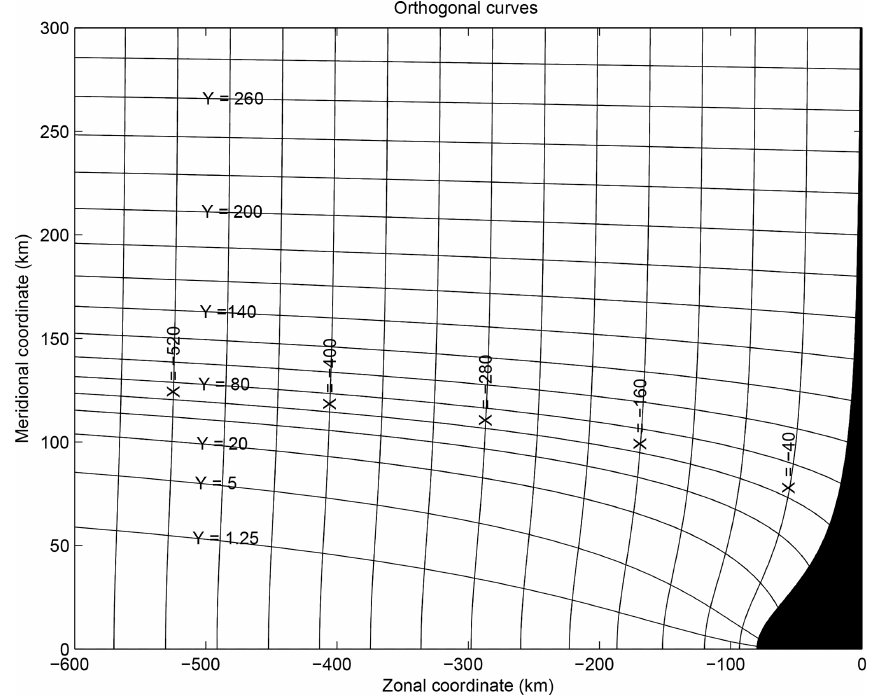
Figure 9. Example of orthogonal coordinates X and Y defined for a cape protruding from the coast into the sea over a distance of 80km. Several values of X and Y have been indicated. Only one half of the domain has been represented.